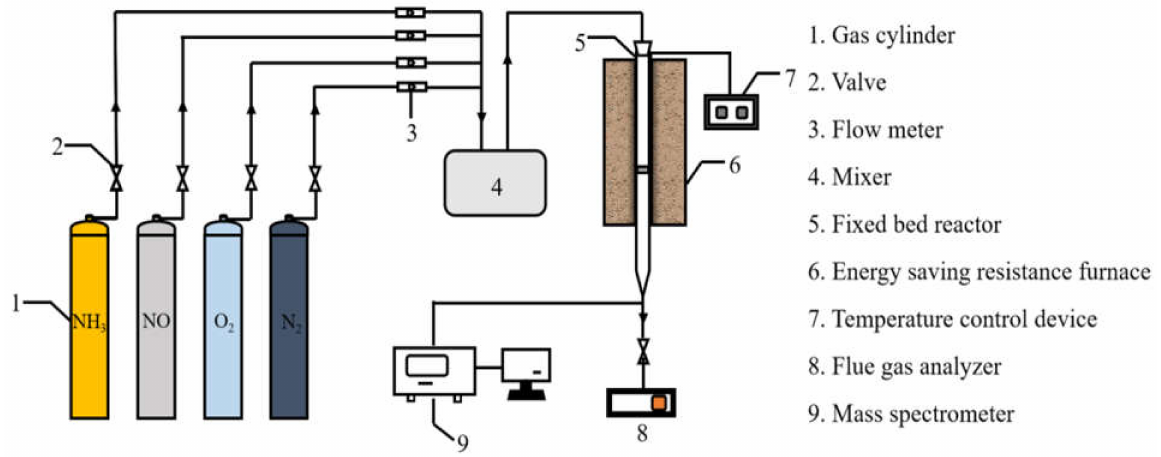
Figure 14. The self-designed fixed-bed catalysis system for SCR reaction and detection. The denitrification performance of catalysts was based on the NO conversion (X NO